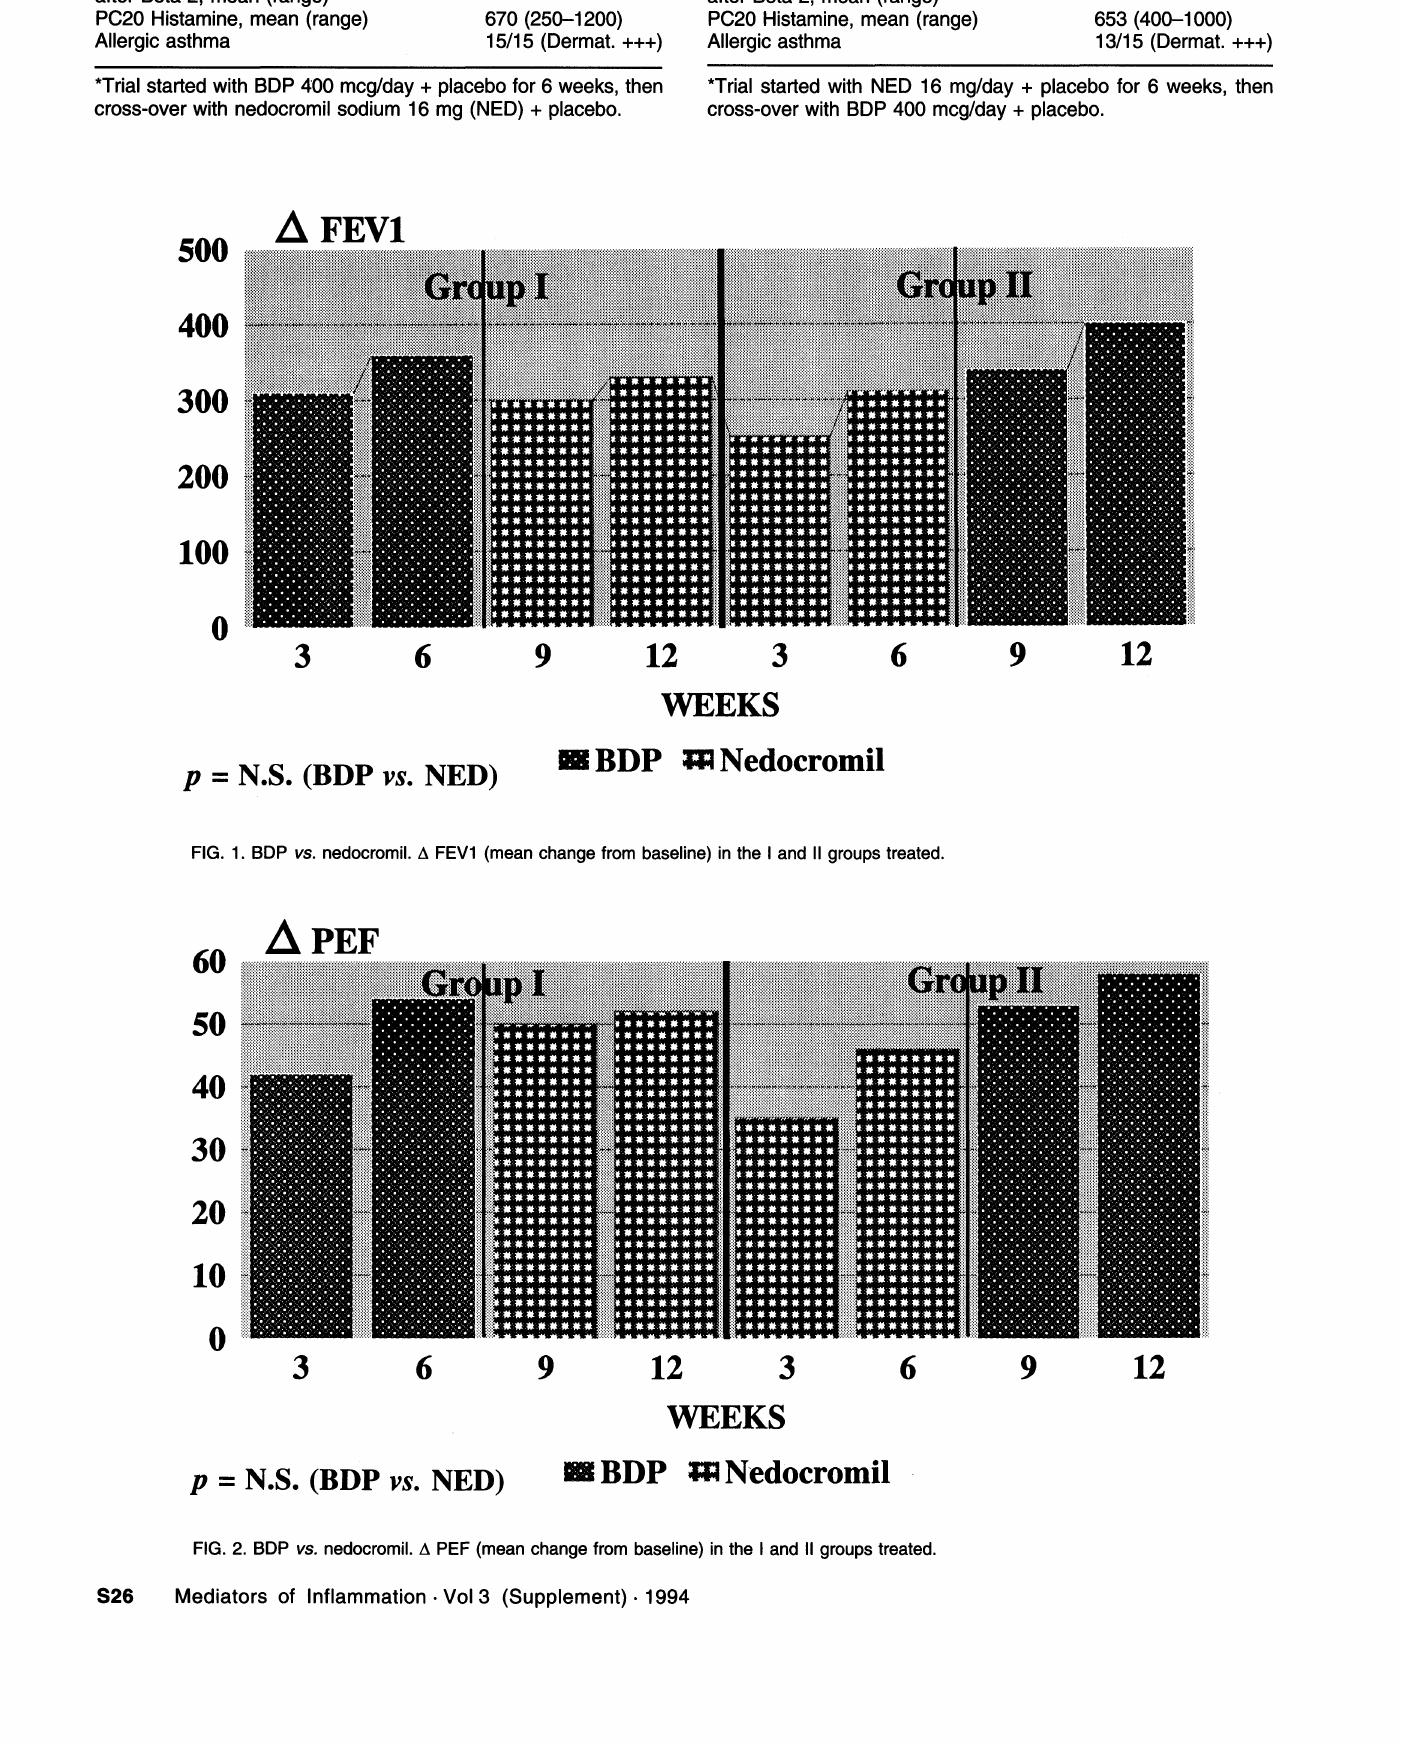
FIG. 2. BDP vs. nedocromil./ PEF (mean change from baseline) in the and II groups